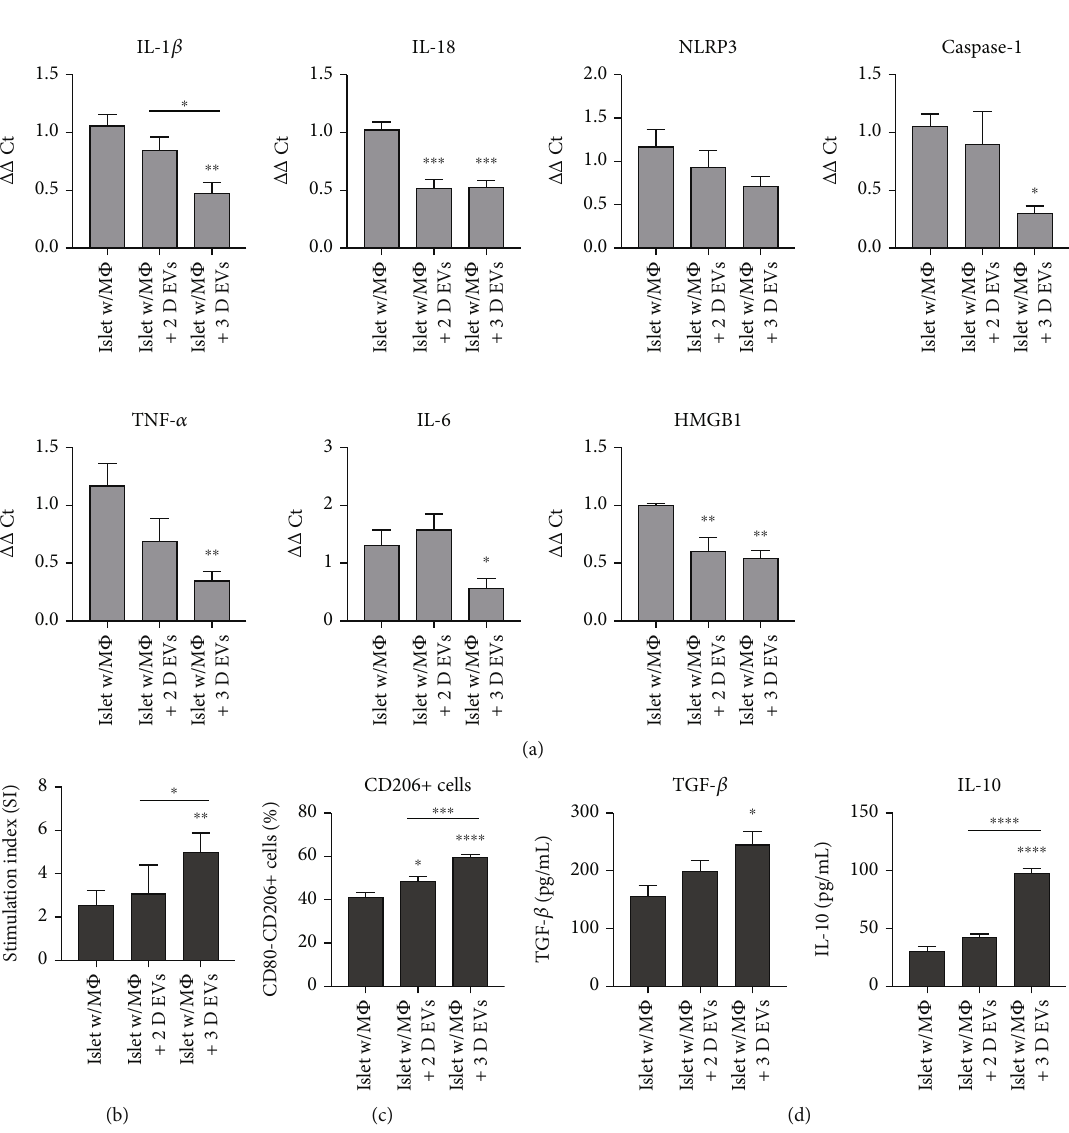
Figure 5: M2 polarization ability of hUCB-MSC-derived EVs in a coculture system of islets and pancreatic macrophages. In a transwell system, 50 islets and 1 × 10 6 macrophages were cultured under three conditions: islets with macrophages without hUCB-MSC-derived EVs (islet w/M Φ ), islets with macrophages with 2D hUCB-MSC-derived EVs (islet w/M Φ +2D EVs), and islets with macrophages with 3D hUCB-MSC-derived EVs (islet w/M Φ +3D EVs). (a) Concentrations of IL-1 β , IL-18, NLRP3 in fl ammasome, caspase-1, TNF- α , IL-6, and HMGB1in cocultured hIAPP +/- islet cells treated with EV produced by 2D- or 3D-cultured hUCB-MSCs were measured using qRT- PCR. The error bars represent the standard deviation of measurements in three separate sample runs ( n = 9 ). (b) Glucose-stimulated insulin secretion (GSIS) of hIAPP +/- mouse islets in each group. GSIS was evaluated using ELISA at 48 h after statin incubation of islets in low (60 mg/dL) and high (300mg/dL) glucose. The error bars represent the standard deviation of measurements in three separate sample runs ( n = 6 ). (c) Flow cytometry analysis of cell surface molecules CD206 and CD80 on macrophages cultured in the presence of EVs. The error bars represent the standard deviation of measurements in three separate sample runs ( n = 9 ). (d) Medium concentrations of TGF- β and IL-10 were measured by ELISA. The error bars represent the standard deviation of measurements in four separate sample runs ( n = 9 ). Columns, mean; bars, SD. ∗ p < 0 : 05 , ∗∗ p < 0 : 005 , ∗∗∗ p < 0 : 0005 , and ∗∗∗∗ p < 0 : 0001 by one-way ANOVA and Tukey ’ s